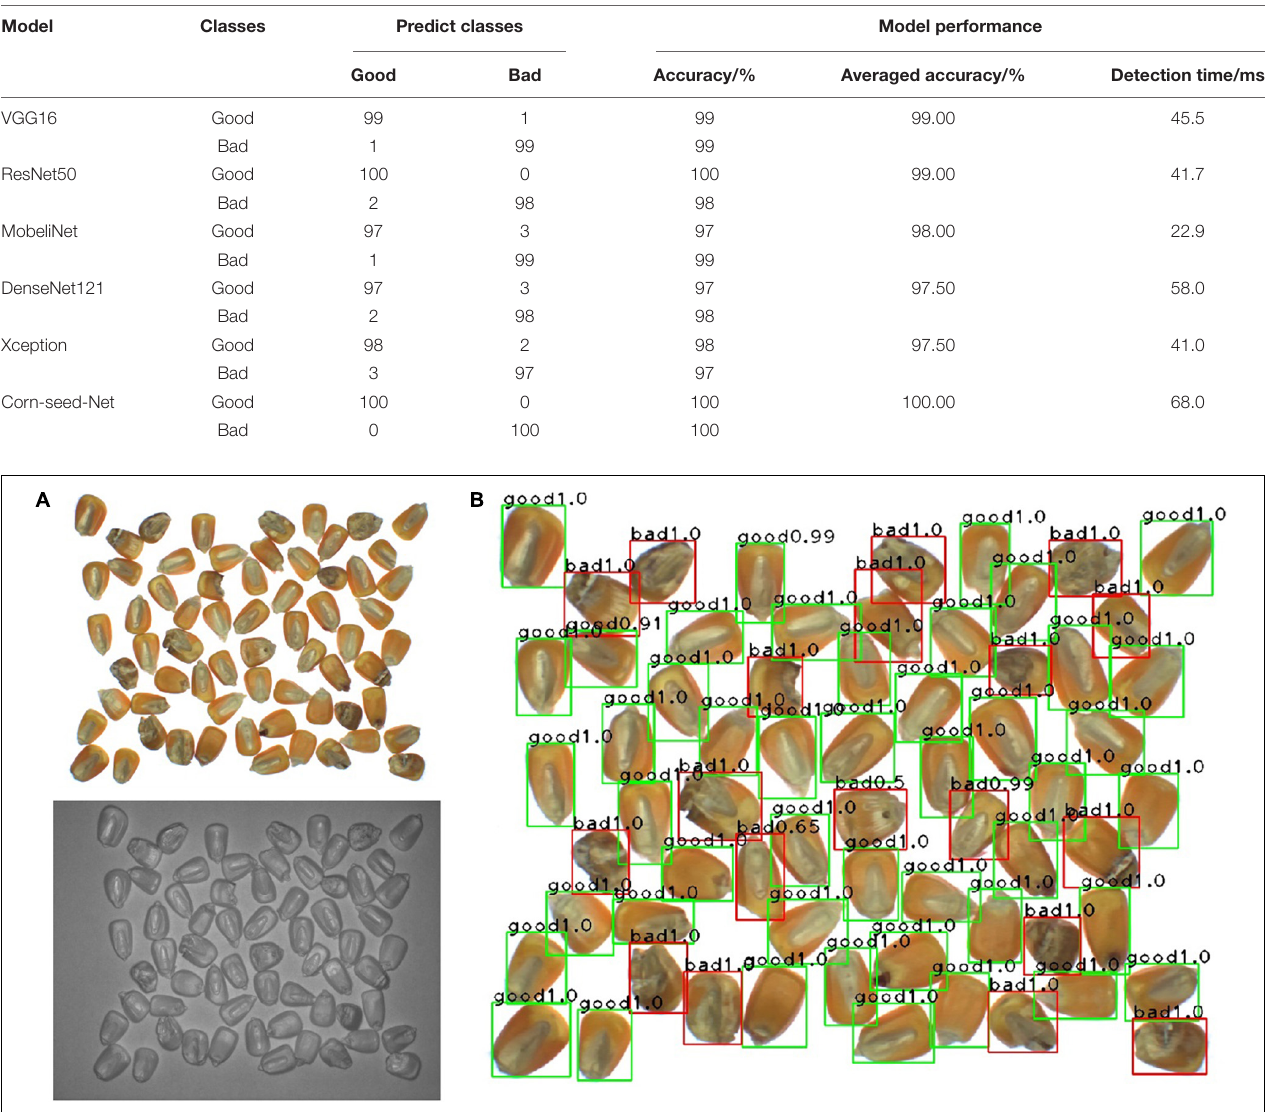
TABLE 2 | Test results of single seed with different models.